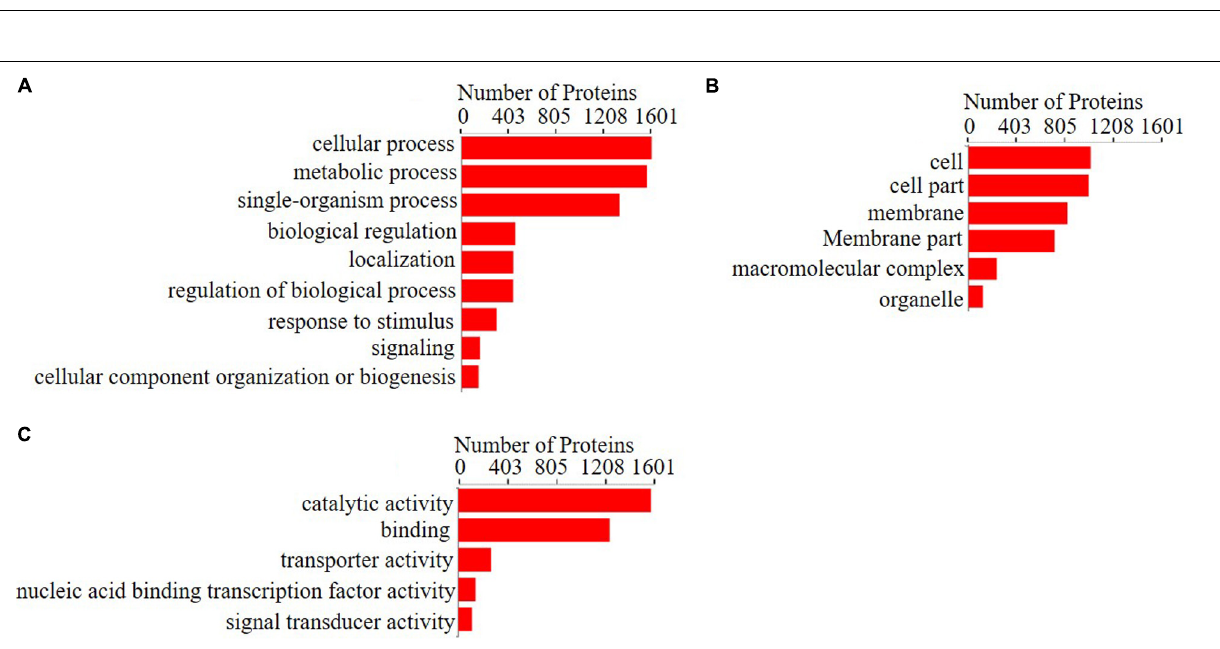
Frontiers in Microbiology |